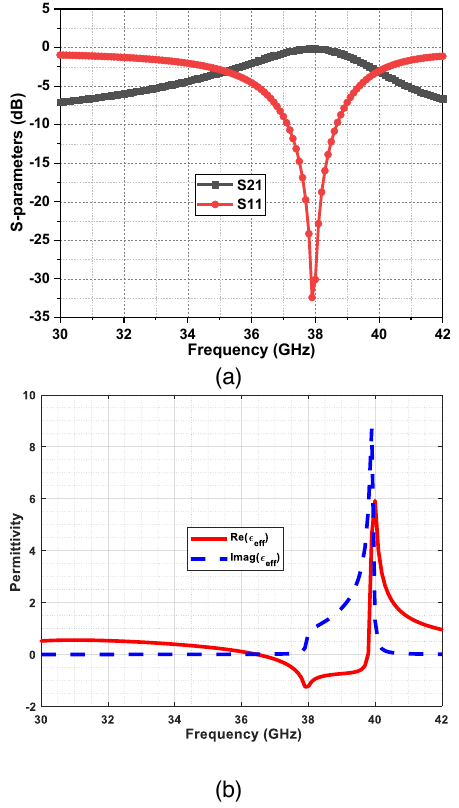
The CSRR unit cell: (a) S-parameters and (b) permittivity parameter.